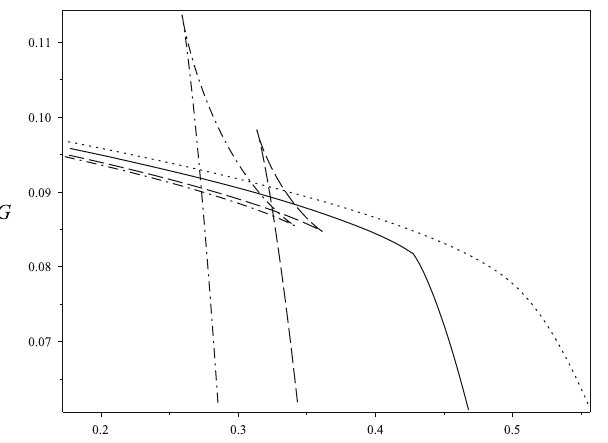
dashed curve corresponds to the value P = P c / 2, a dash-dotted line corresponds to the value P = P c / 3 and finally a dotted curve corre- sponds to the pressure P = 3 P c / 2